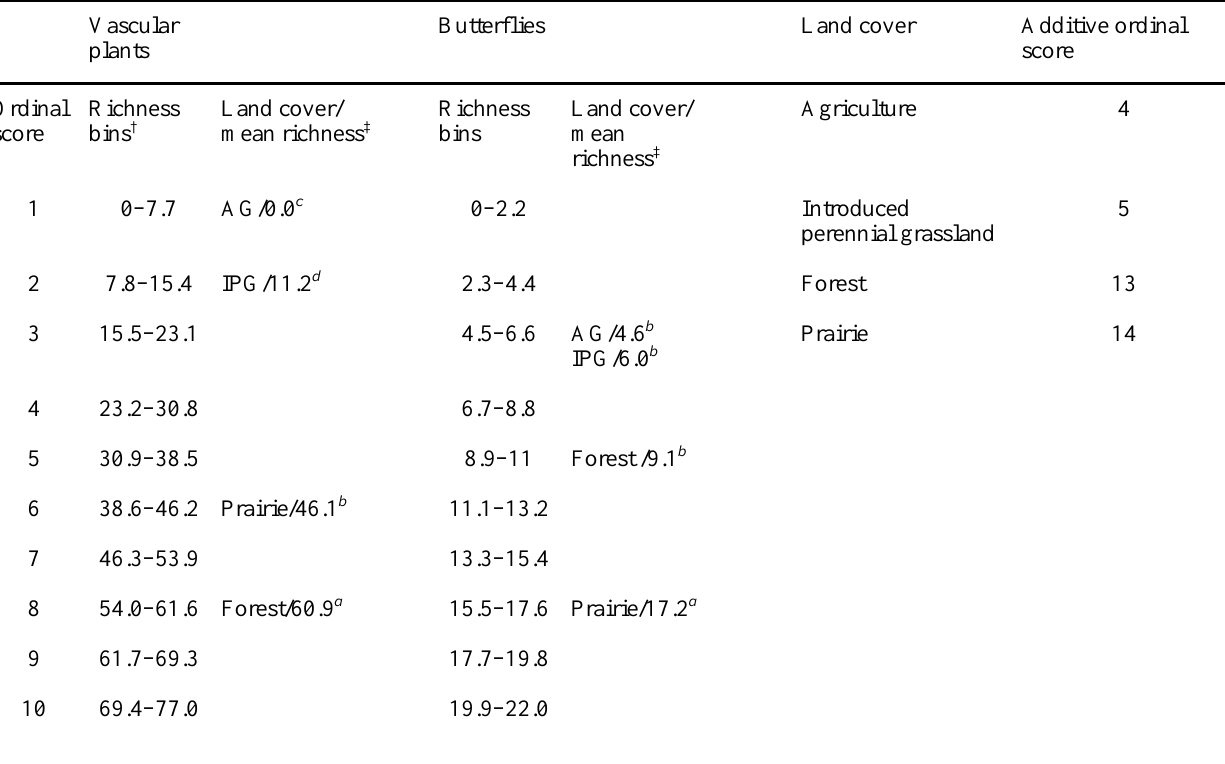
Table 7 . Mean richness, ordinal scales, and additive ordinal scores used to identify land covers with higher biodiversity